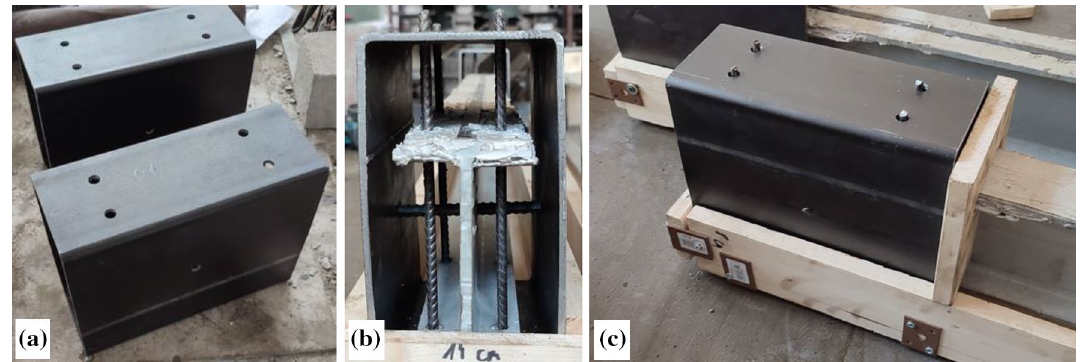
Figure 4. Preparing the modified support blocks: ( a ) rectangular steel tube with drilled holes; ( b ) inserted 6 mm and 8 mm bars; ( c ) the steel tube inside the form.